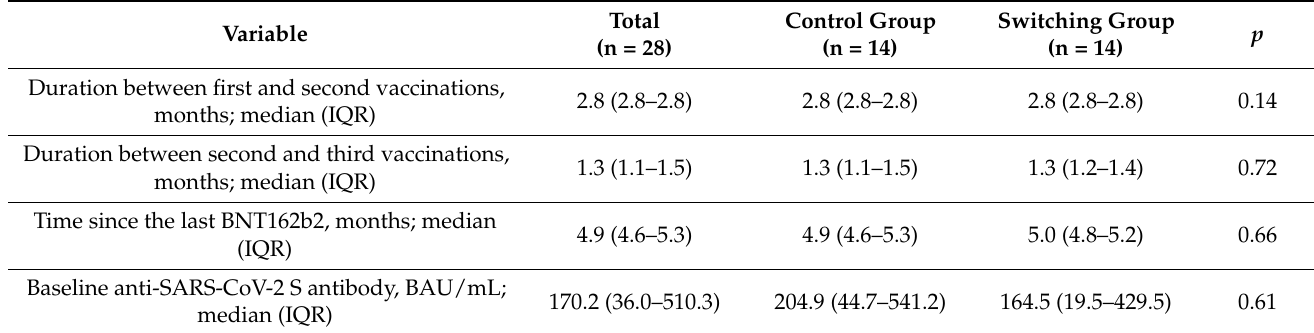
Figure 1. Flow diagram of the study participants.